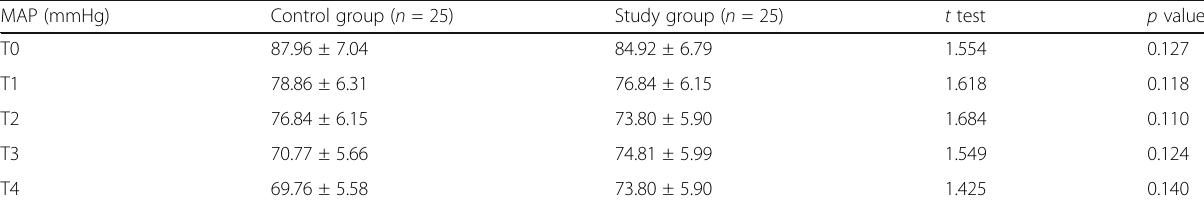
Table 3 MAP (mmHg)